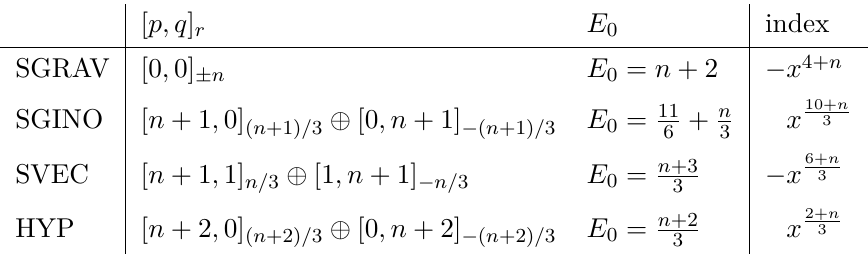
Table 1 . The spectrum of the short multiplets at the Kaluza-Klein level n and the contributions